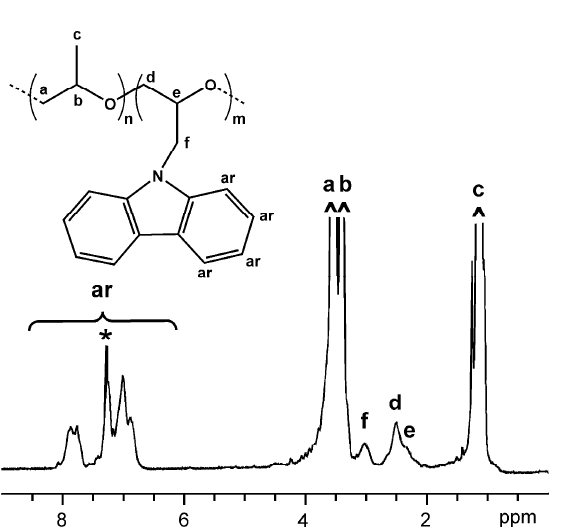
Figure 2. 1 H NMR spectrum of PPO- b -PEPK copolymer sample 2 (solvent: CDCl 3 (*); TMS scale; T = 25 °C). Table 2. Chem. shift assignments of the carbon atoms in PPO- b -PEPK 13 C NMR